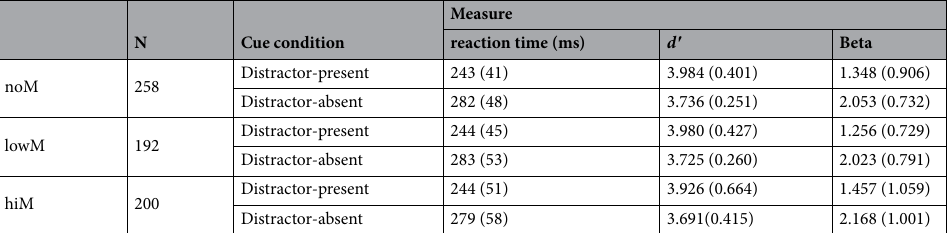
Table 1. Mean reaction time, d’ and beta across subjects for the distractor interference task in Study 1, as a function of cue condition and MkAQ scores (noM = a sum score of 0 or 1 lowM = a sum score of 2–5, hiM = a sum score of 6 or higher). Total participants (N) in each group. Mean values, with standard deviations in parentheses.